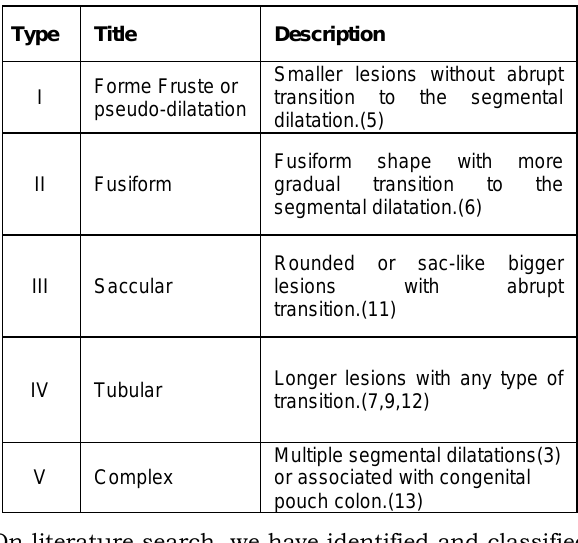
Table 1: Morphological spectrum of congenital segmental dilatation of intestine identified on literature